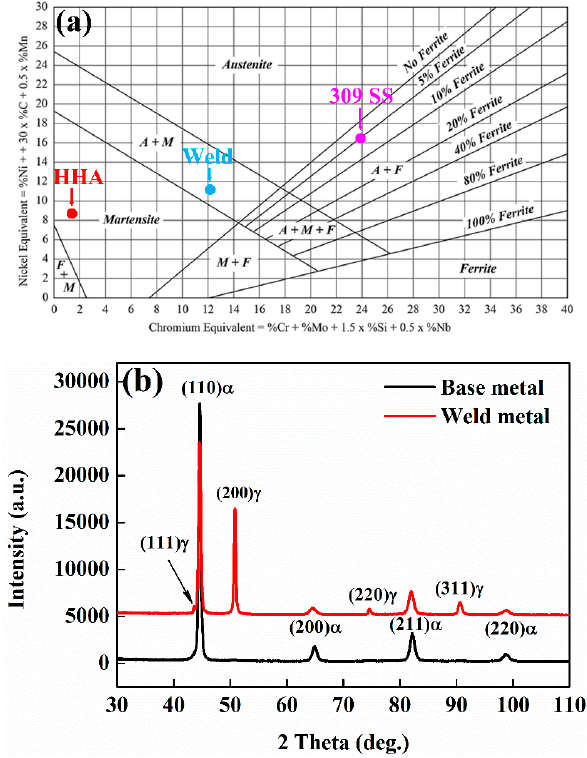
Figure 5. Phase constituents in weld and base metal; ( a ) Schae ffl er diagram; and ( b ) XRD